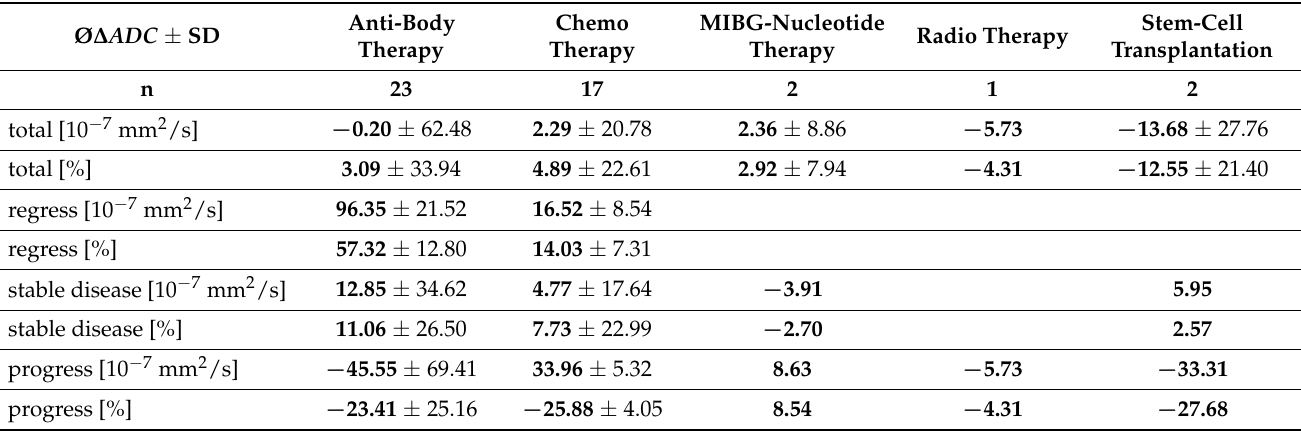
Figure 9. Mean percentage ∆ ADC values (whiskers = 1 SD) according to the type of therapy and disease progression. Here, too, significant differences could not be seen between the changes depending on the type of therapy. Table 5. Mean ∆ ADC values (bold) ± SD according to the type of therapy and the course of the disease. Significant differences could not be seen between the changes depending on the type of